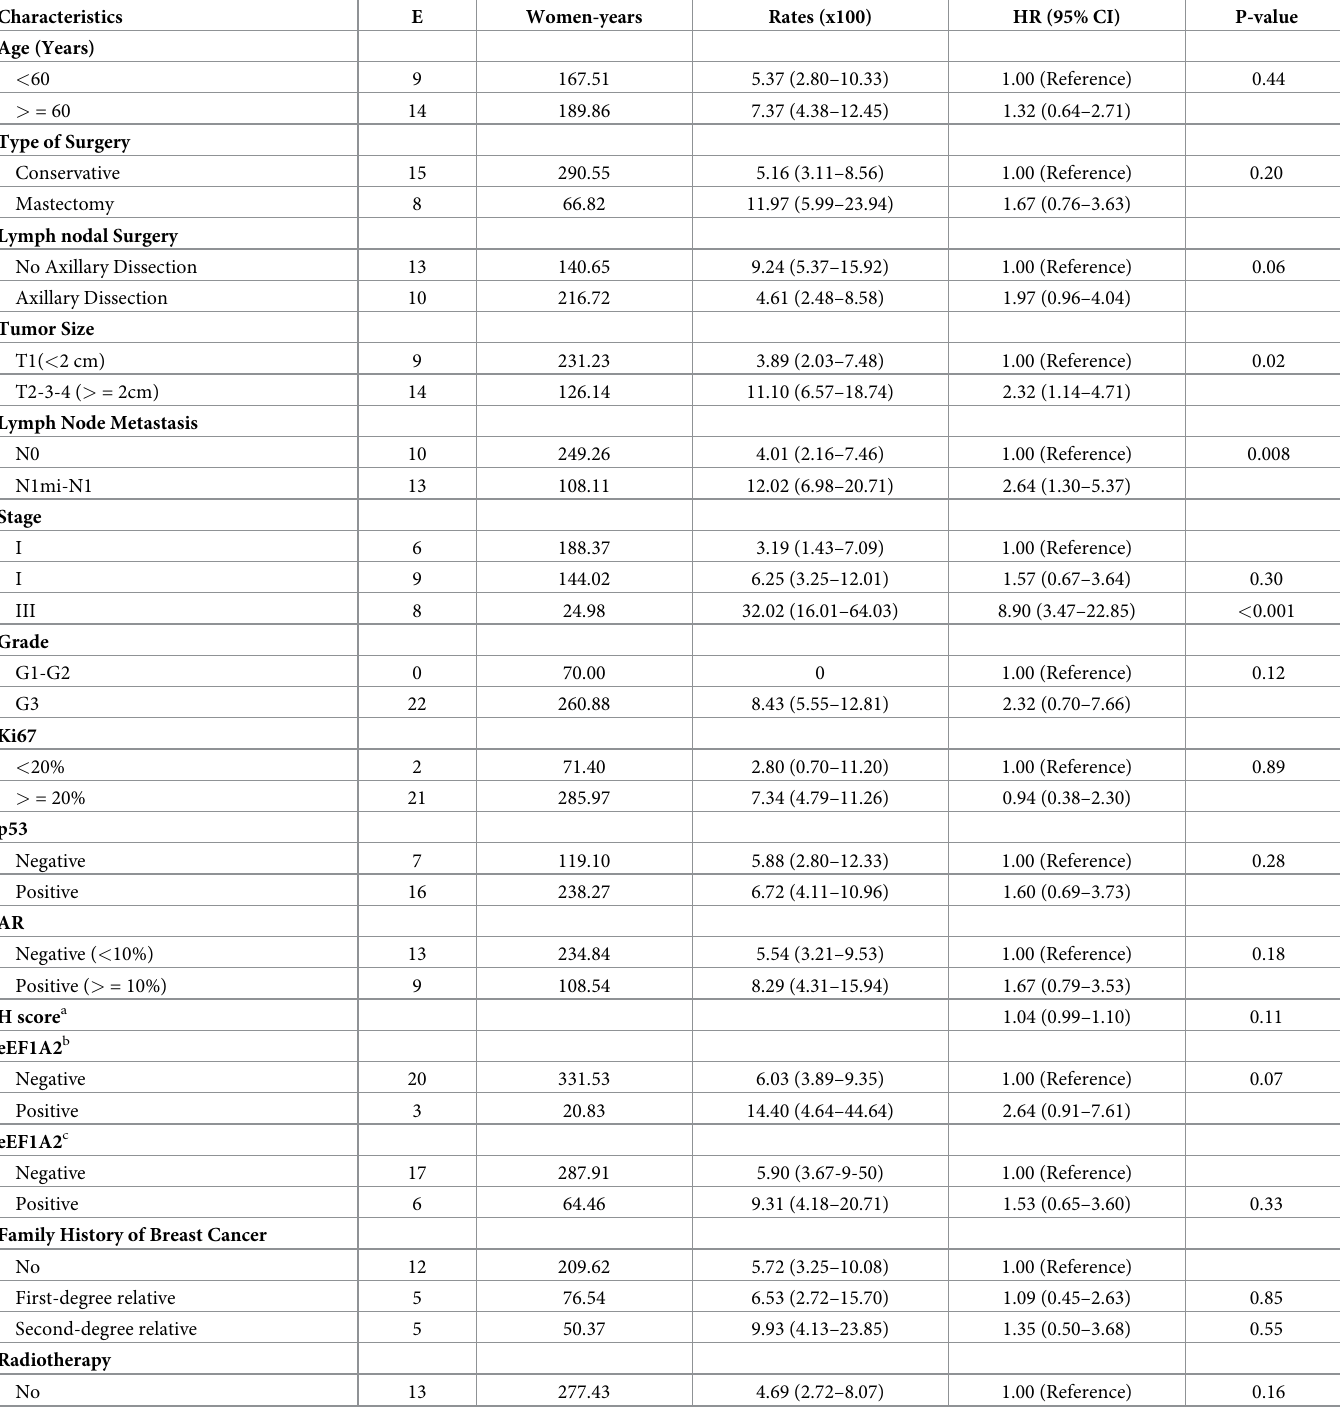
Table 3. Results from univariate Cox models for